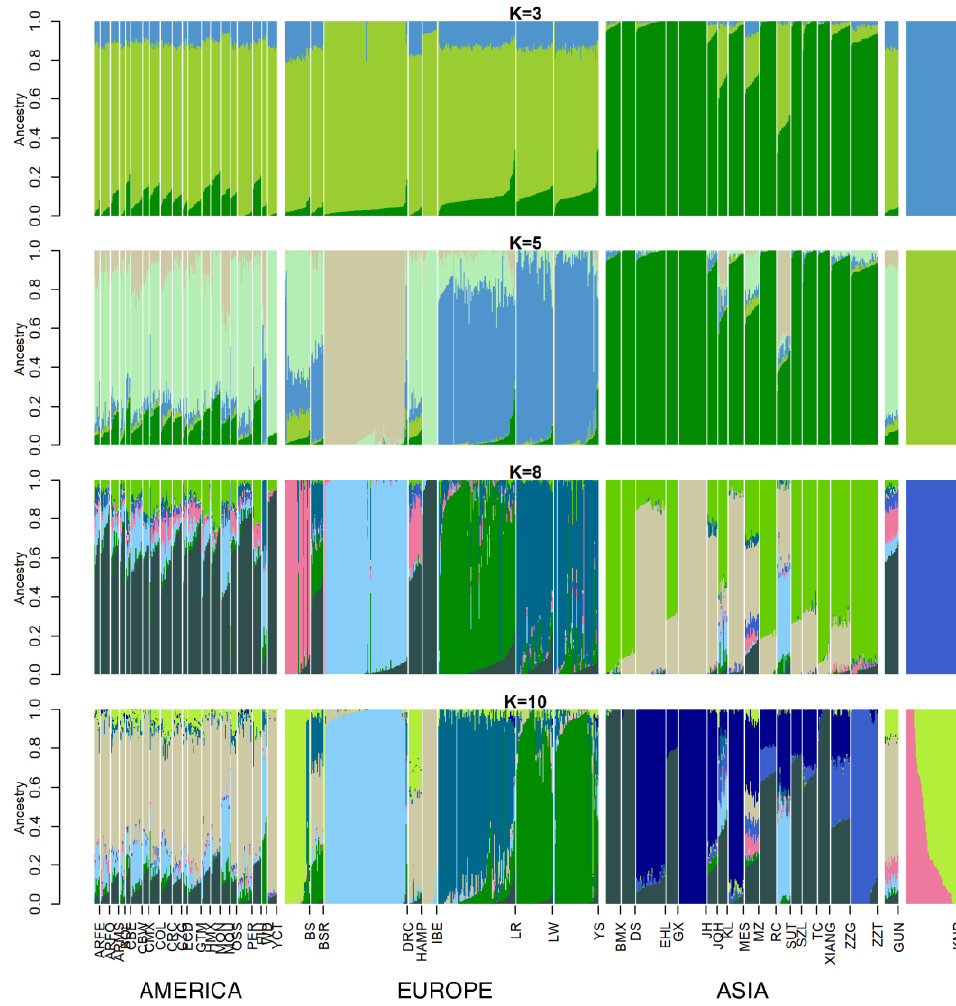
Figure 2. Ancestry analysis of the pig populations with admixture. (Argentina Feral (ARFE), Argentina Formosa Semi Feral (ARFO), Argentina Misiones Creole (ARMS), Bamaxiang (BMX), Bolivia Creole (BOL), Berkshire (BS), Bisaro (BSR), Cuba Eastern Creole (CBE), Cuba Western Creole (CBW), Mexico Cuino (CMX), Colombia Creole (COL), Costa Rica Creole (CRC), Colombia Zungo (CZG), Duroc (DRC), Dongshan (DS), Ecuador Creole (ECD), Erhualian (EHL), Guatemala Creole (GTM), Guinea Hog (GUN), Ganxi (GX), Hampshire (HAMP), Mexico Hairless (HMX), Iberian (IBE), Jinhua (JH), Jiangquhai (JQH), Kele (KL), Korean Native (KNP), Landrace (LR), Large White (LW), Meishan (MES), Brazil Monteiro (MON), Brazil Moura (MOU), Min (MZ), Ossabaw (OSS), Peru Creole (PER), Brazil Piau (PIU), Rongchang (RC), Sutai (SUT), Shaziling (SZL), Tongcheng (TC), White Duroc (WD), Xiang Pig (XIANG), Yucatan (YCT), Yorkshire (YS), Tibetan Gansu (ZZG), Tibetan Tibet (ZZT).)